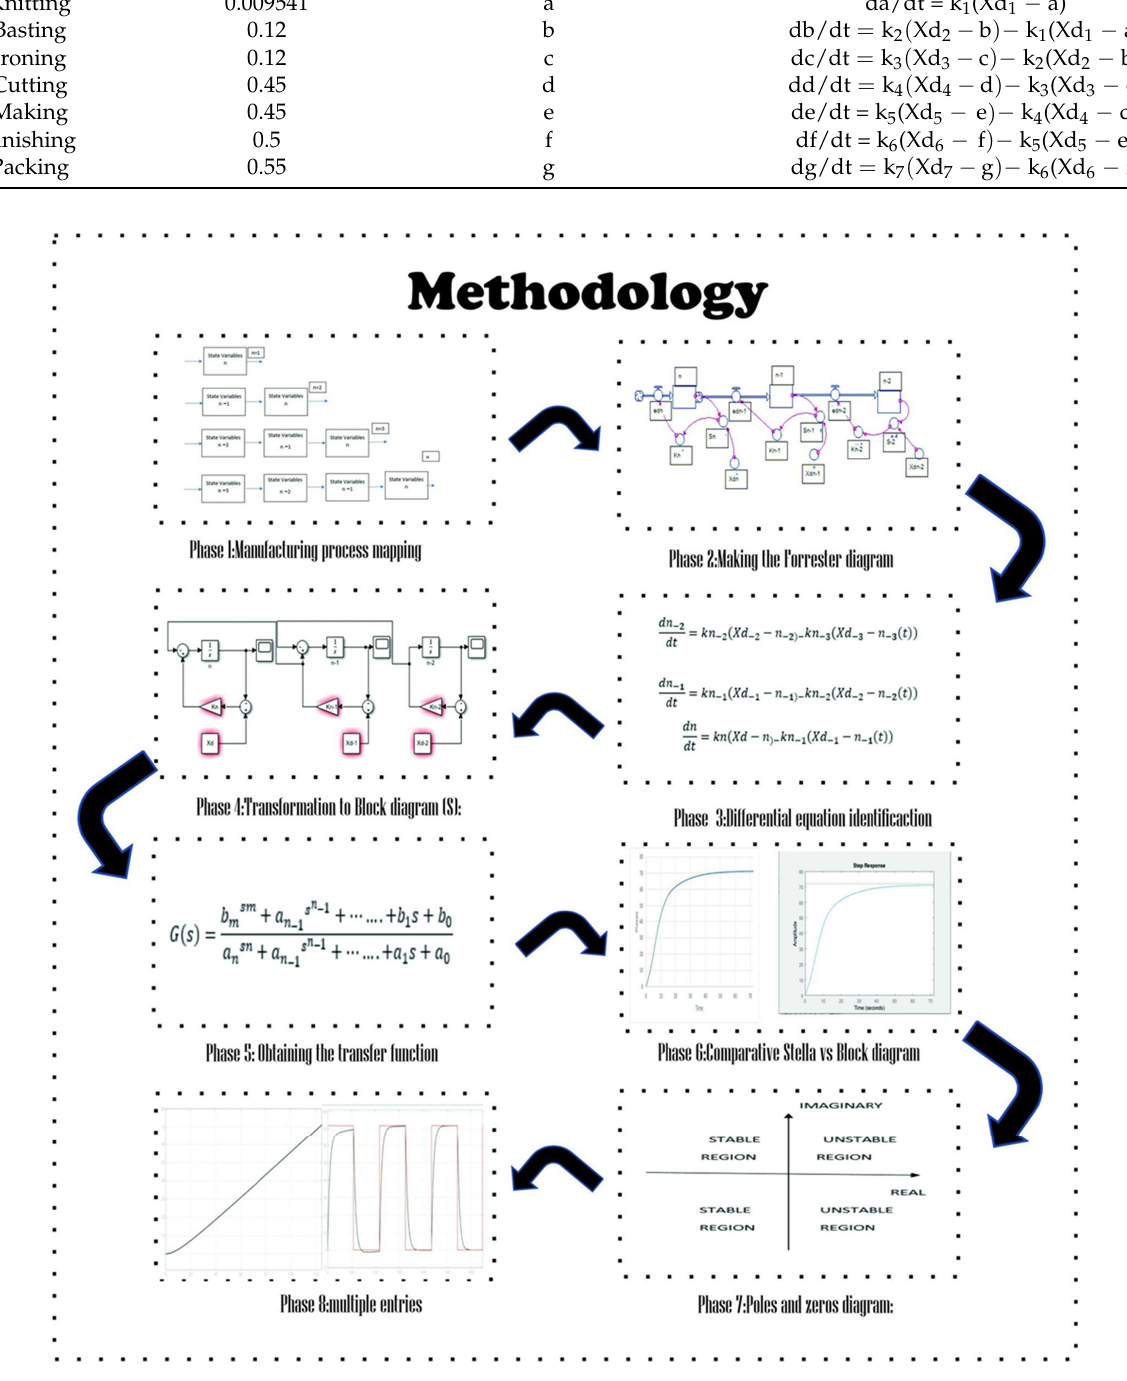
Figure 1. System dynamics methodology. Manufacturing process mapping: a mapping is made of the operations involved in the manufacturing process studied and carried out ascendingly until